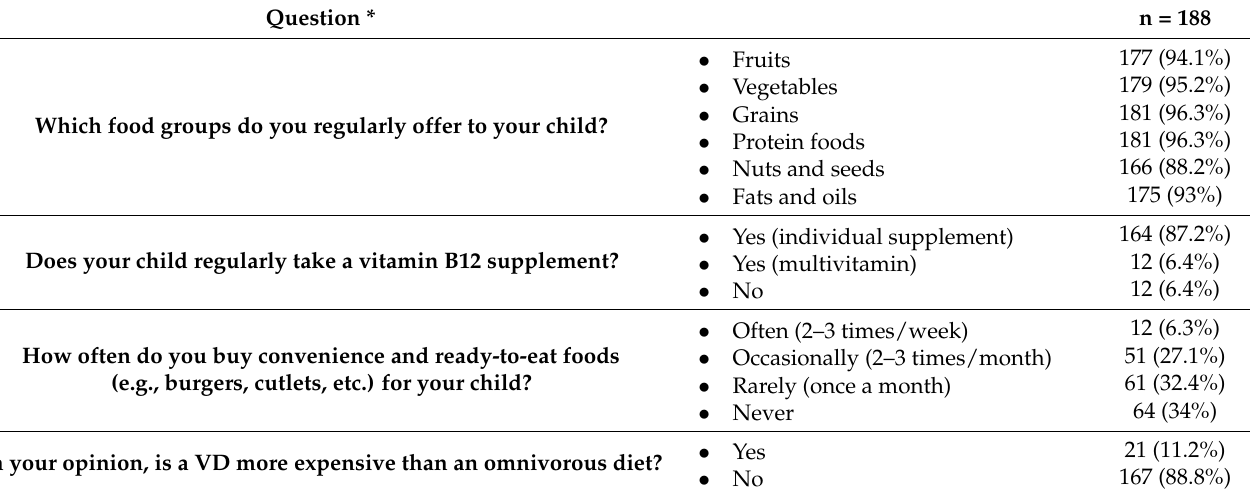
Table 4. Parents’ answers to questions aimed at evaluating: Administration of food groups, vitamin B12 supplementation and convenience foods to their offspring.